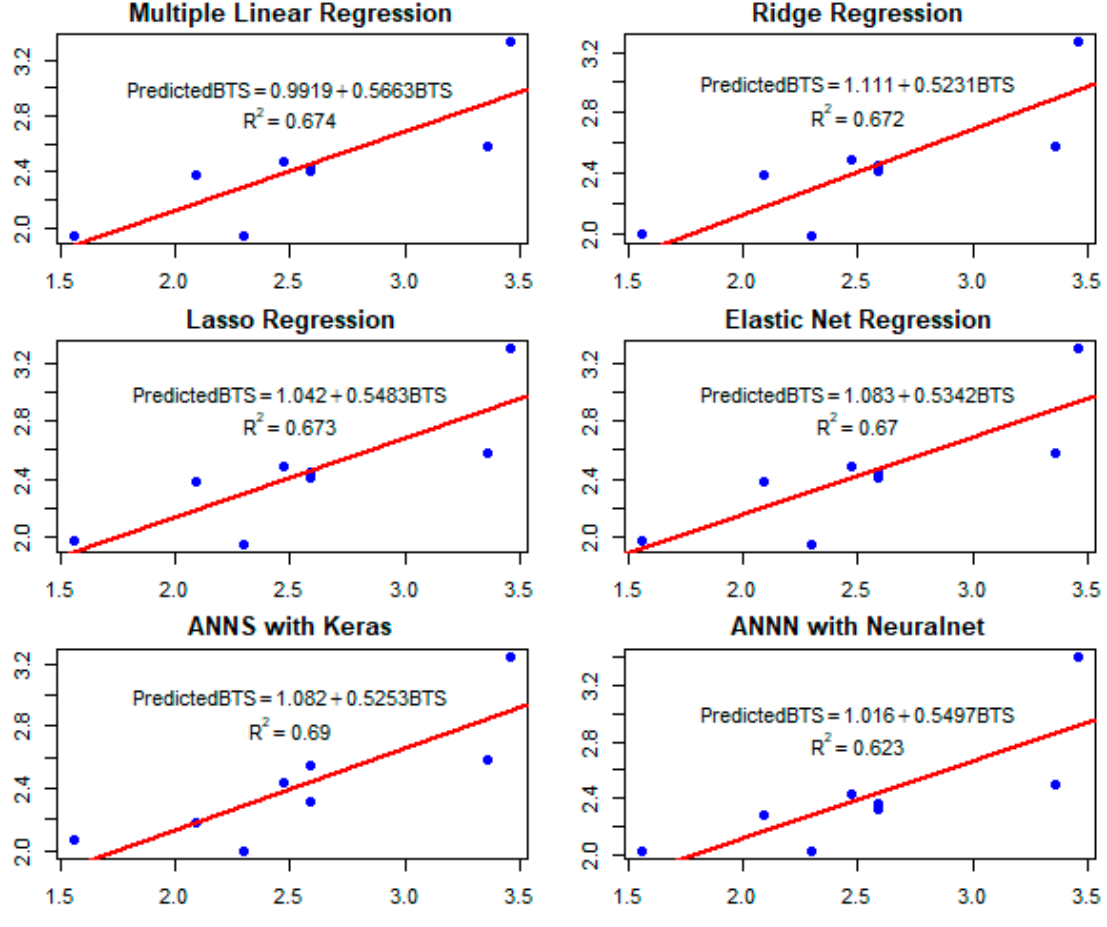
Figure 10. BTS predicted values.